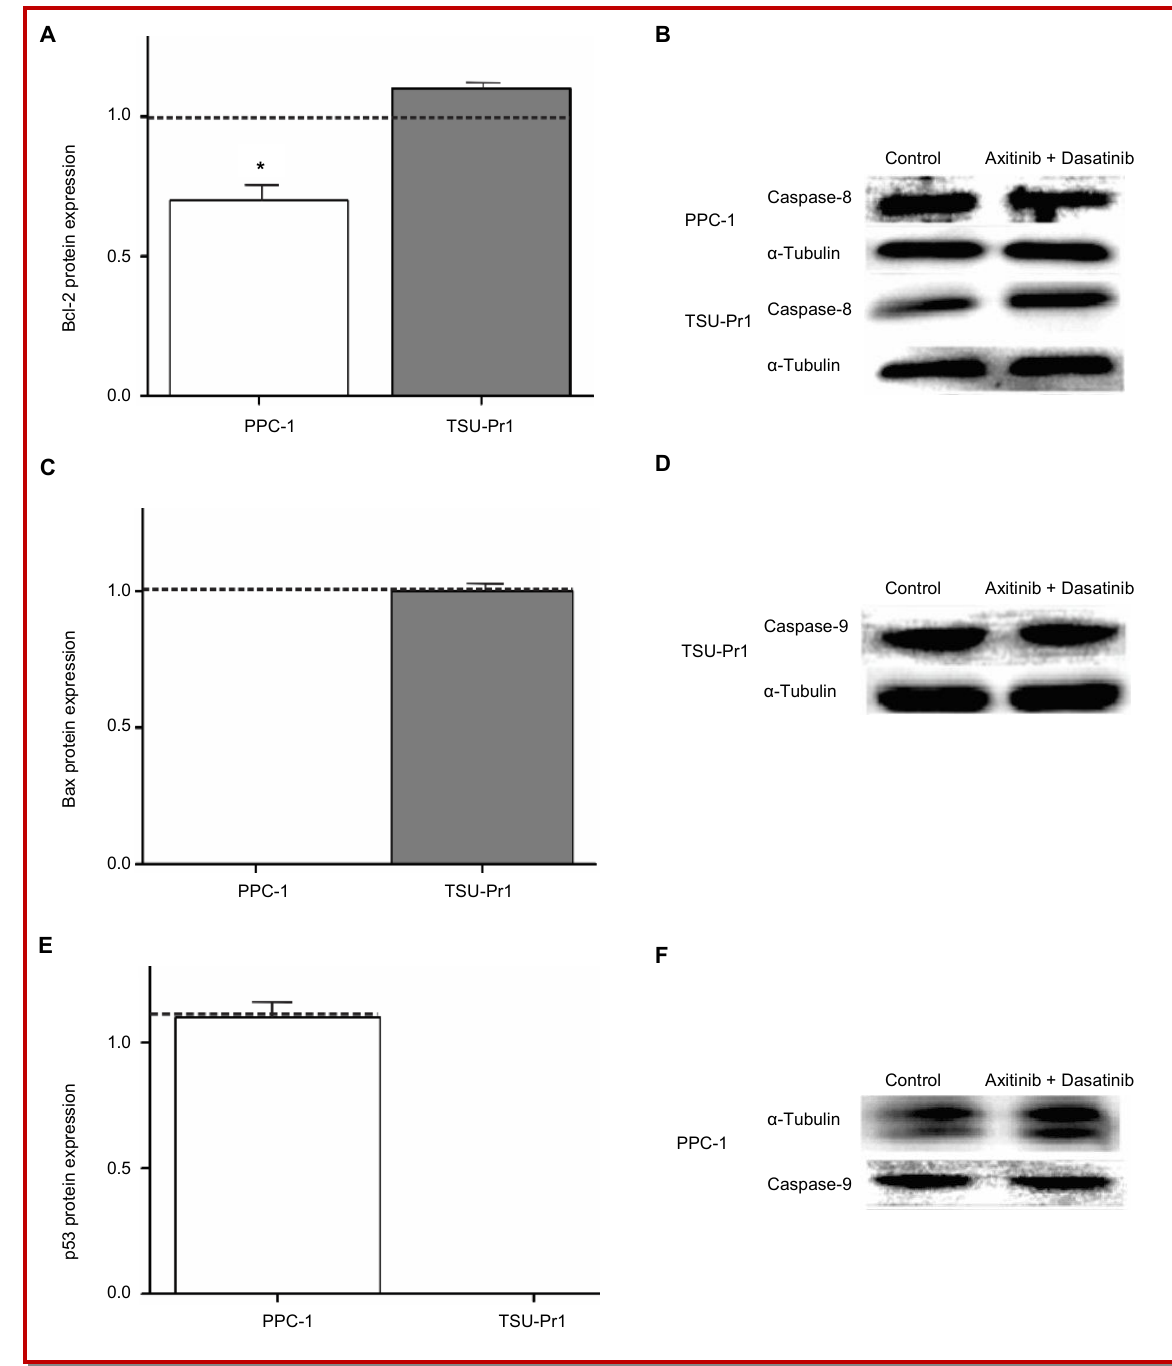
Figure 4: Effect of axitinib and dasatinib (20 mM) on protein levels of Bcl-2 (A, B), Bax (C, D), and p53 (E, F) in PPC-1 and TSU-Pr1 cells determined by Western Blot analysis. Results are expressed as fold-variation relatively to control (dashed line) after normali- zation with